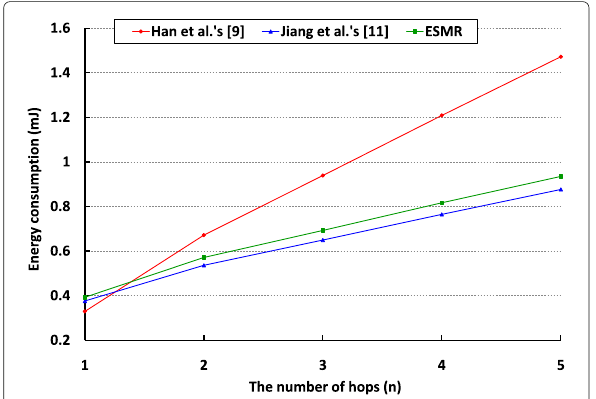
Fig. 6 Total energy consumption for a single